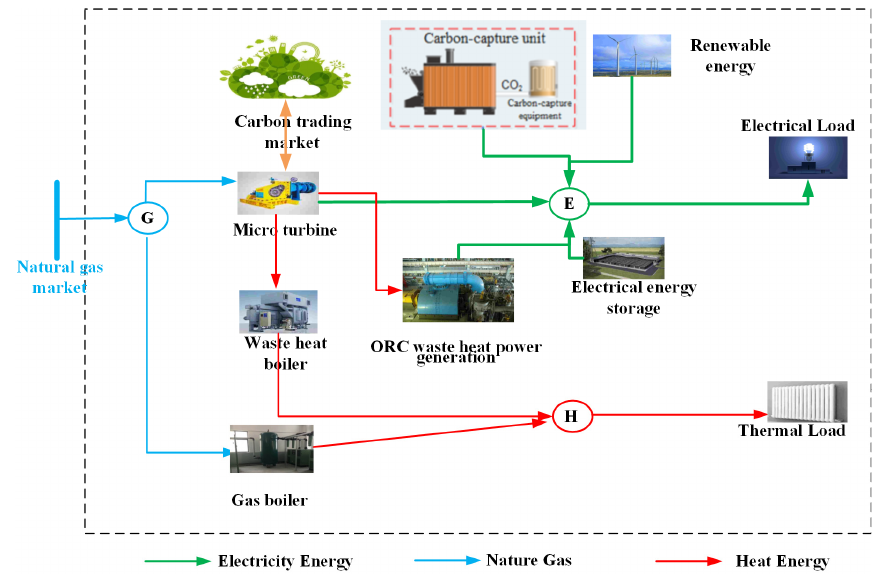
Figure 1. MEVPP system structure.